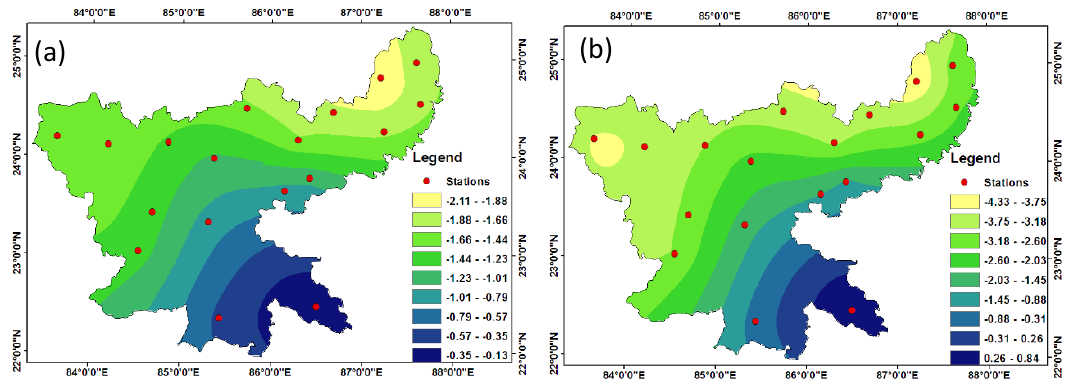
Figure 7. Spatial distribution of temporal change in Annual rainfall during 1901 to 2002 ( a ) and from 1952 to 2002 ( b ).